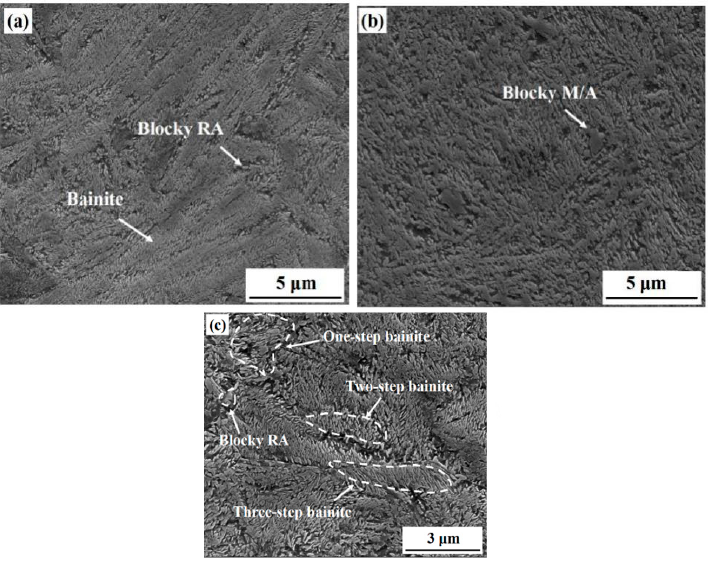
Figure 3. Scanning electron microscope (SEM) micrographs for samples ( a , c ) three-step low temperature bainitic transformation (B3) and ( b ) quenching and tempering (Q&P).